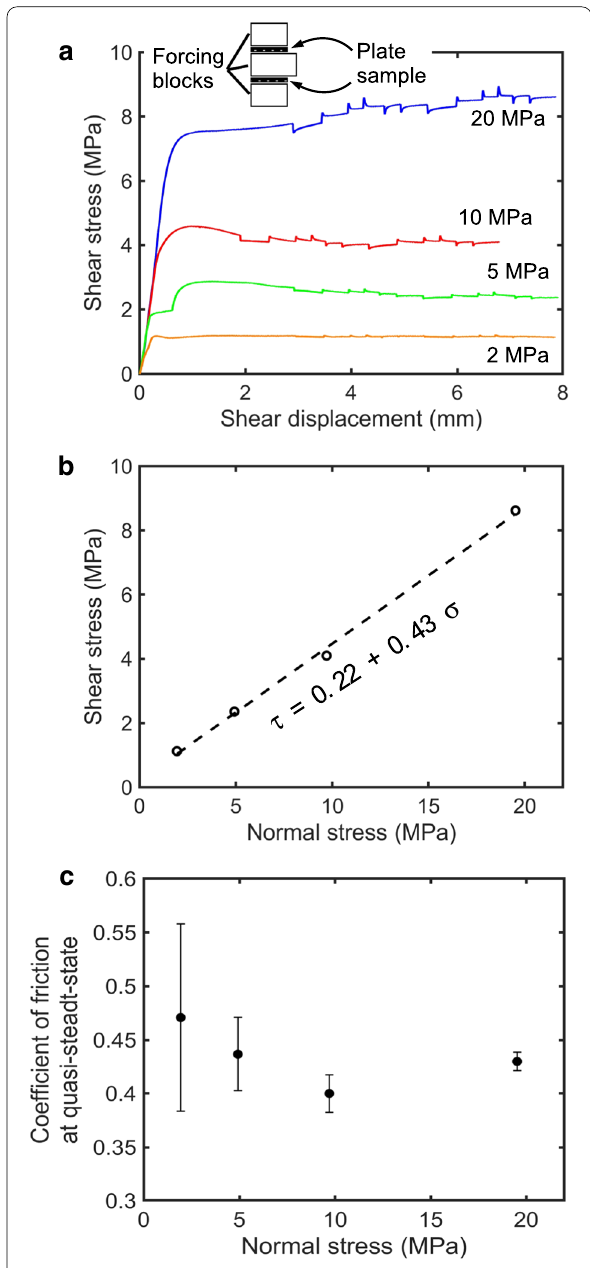
Fig. 4 Mechanical data from velocity‑stepping experiments conducted at elevated normal stresses. a Shear stress versus shear displacement for the samples deformed at 2 (orange), 5 (green), 10 (red) and 20 MPa (blue). The upper left inset displays a schematic of the double‑direct shear configuration. b Steady‑state shear stress ( τ ) as a function of the normal stress ( σ ) at a 1.5‑mm shear displacement where a quasi‑steady‑state is achieved. The friction coefficient and cohesive strength determined by a least‑square fit (coefficient of determination R2 0.9975) with the Mohr–Coulomb linear equation = (dashed lines) were 0.43 ( 0.02) and 0.22 ( 0.17), respectively. c ± ± Quasi‑steady‑state friction coefficient corrected for the cohesive strength (0.22 MPa) as a function of normal